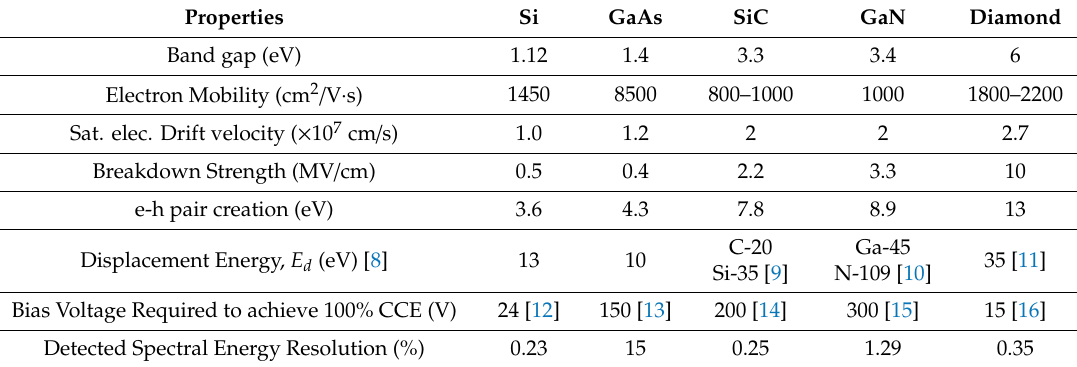
Table 1. Material characteristics of di ff erent semiconductors used for the α -particle detection along with the best-reported detector